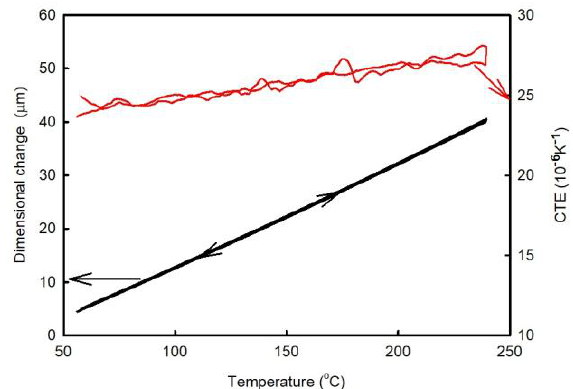
Figure 2. Dilatational characteristics of the calibration Aluminum sample with thickness 7.56 mm. CTE: coefficients of thermal expansion.